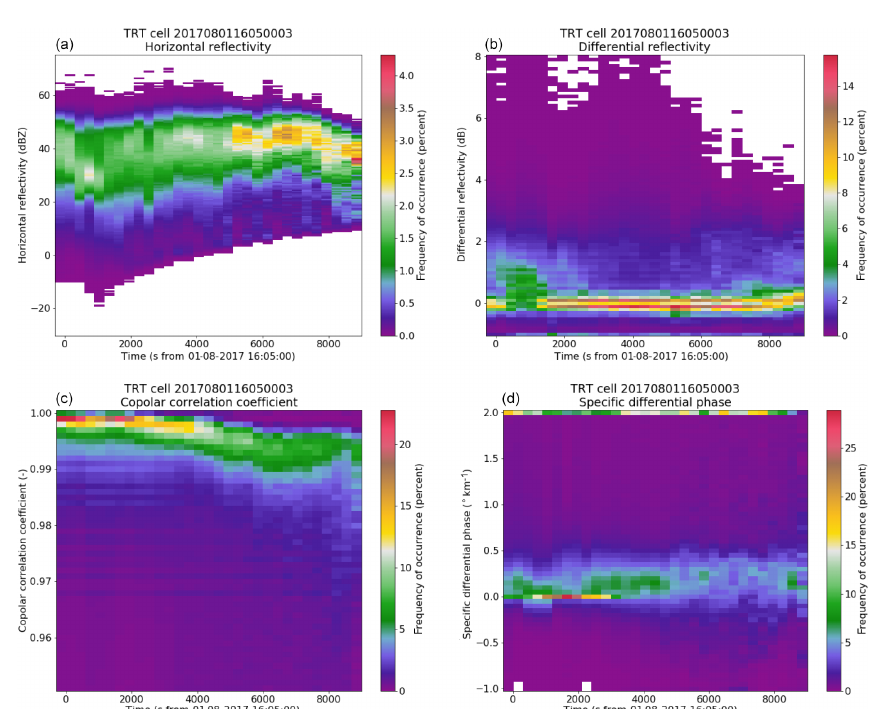
Figure 16. Percentage of occurrence at each time step of from (a, b) to (c, d) and (a, c) to (b, d) : reflectivity, Z dr , ρ hv and K dp for cell 2.